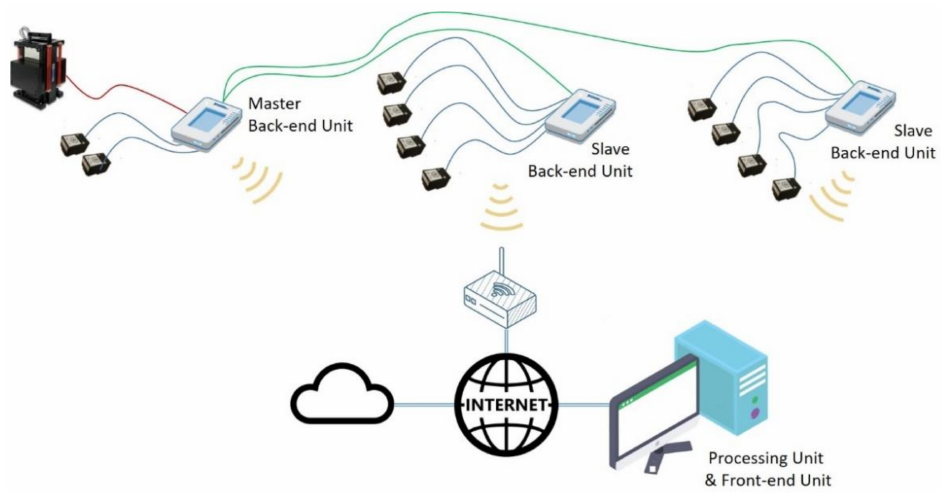
Figure 1. Configuration of the monitoring system.